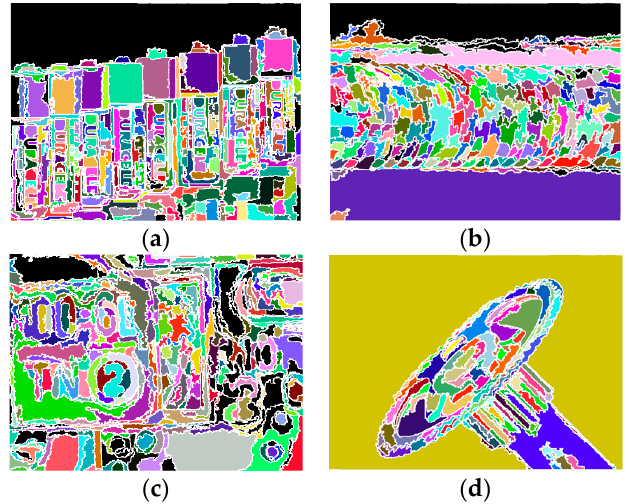
Figure 10. Results of iterative region splitting, x- regions are colored in black, ( a ) “Battery”, ( b ) “Screw”, ( c ) “PCB”, ( d ) “Tool”.